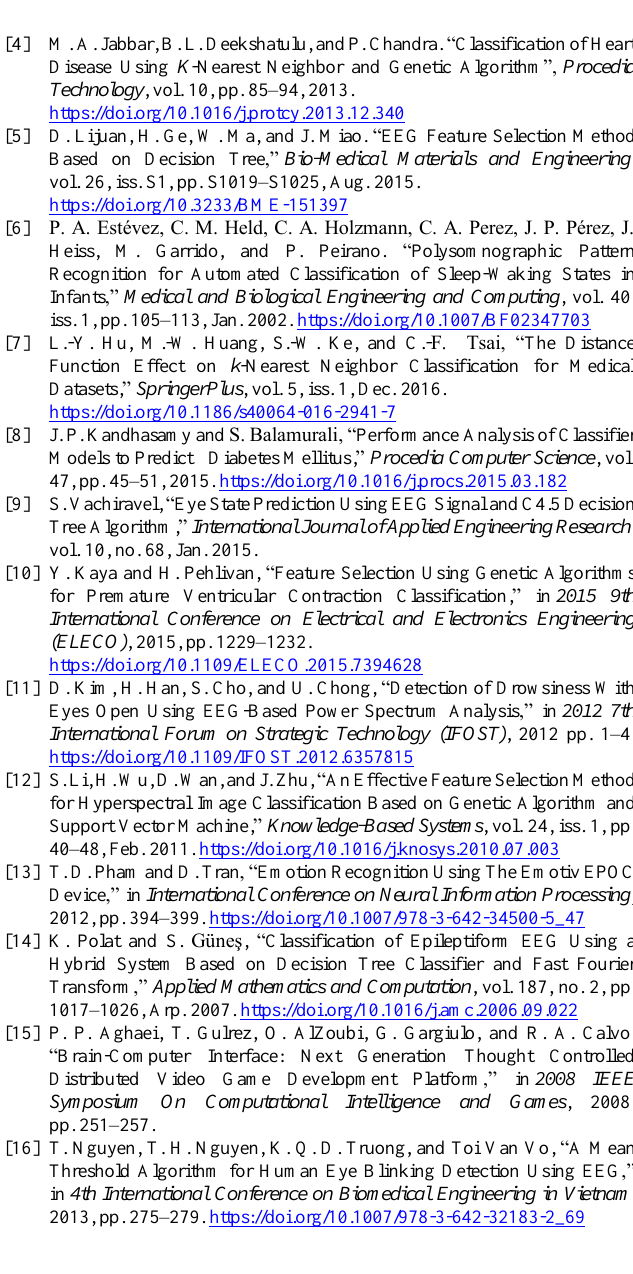
Fig. 7. Number of reduced features after applying feature selection using